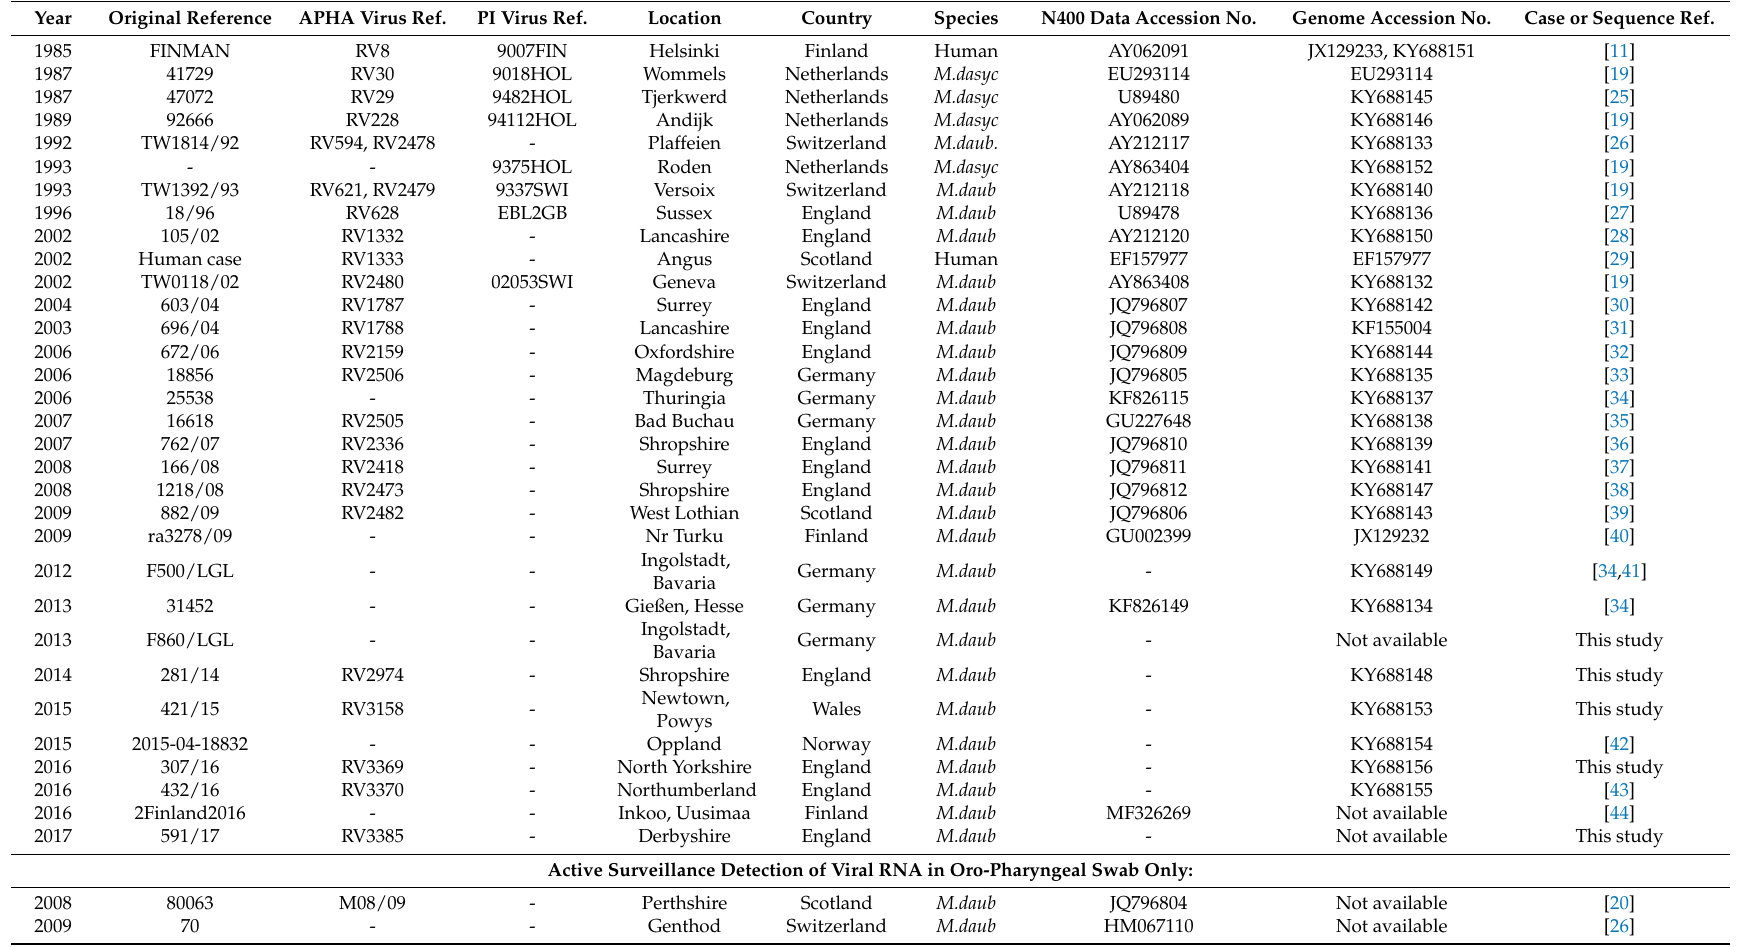
Table 1. Confirmed cases of EBLV-2 in Europe 1985–2017 and sequences used to generate phylogenetic